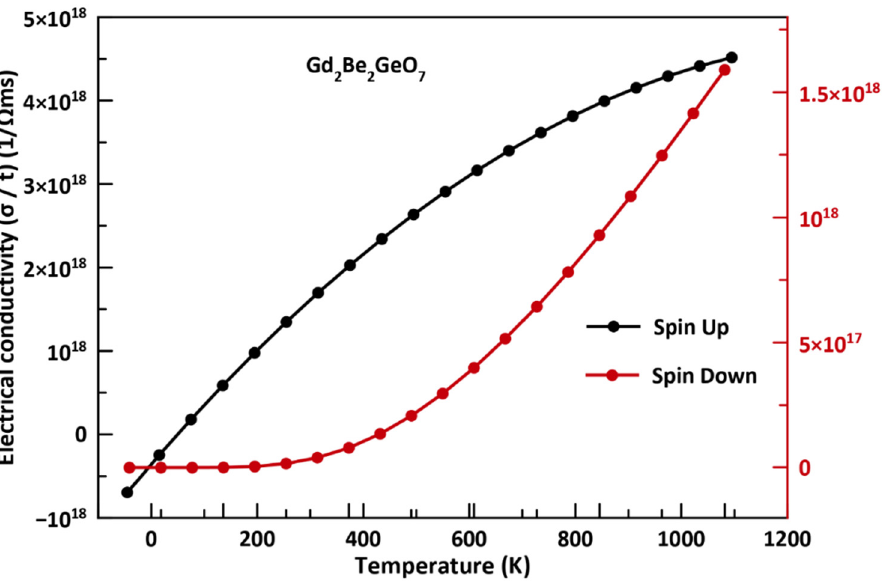
Figure 16. Variation of electrical conductivity ( σ / τ ) in both spin channels (up and down) as a func- tion of temperature for Gd 2 Be 2 GeO 7 compound.